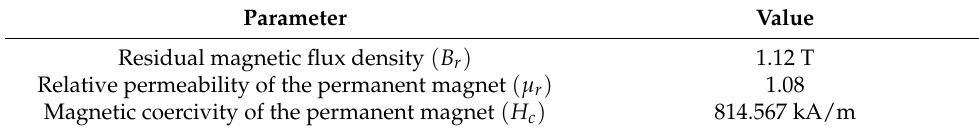
Table 2. Material properties of the permanent